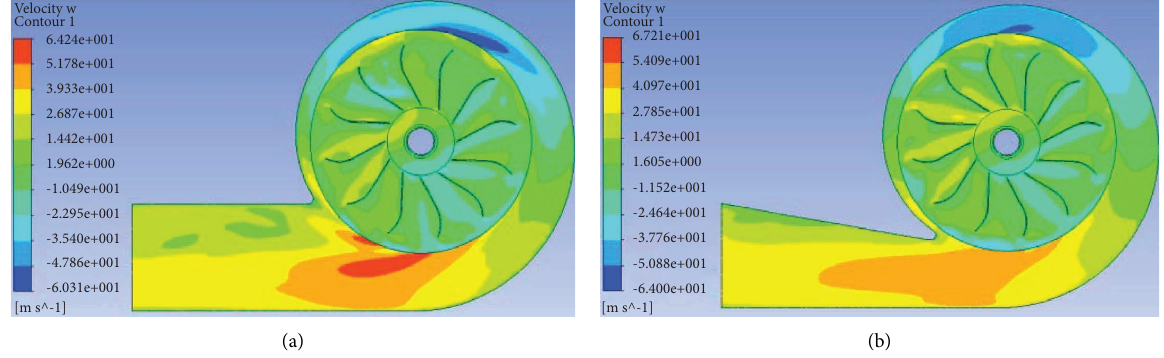
Figure 12: Velocity distribution: (a) before optimization and (b) after